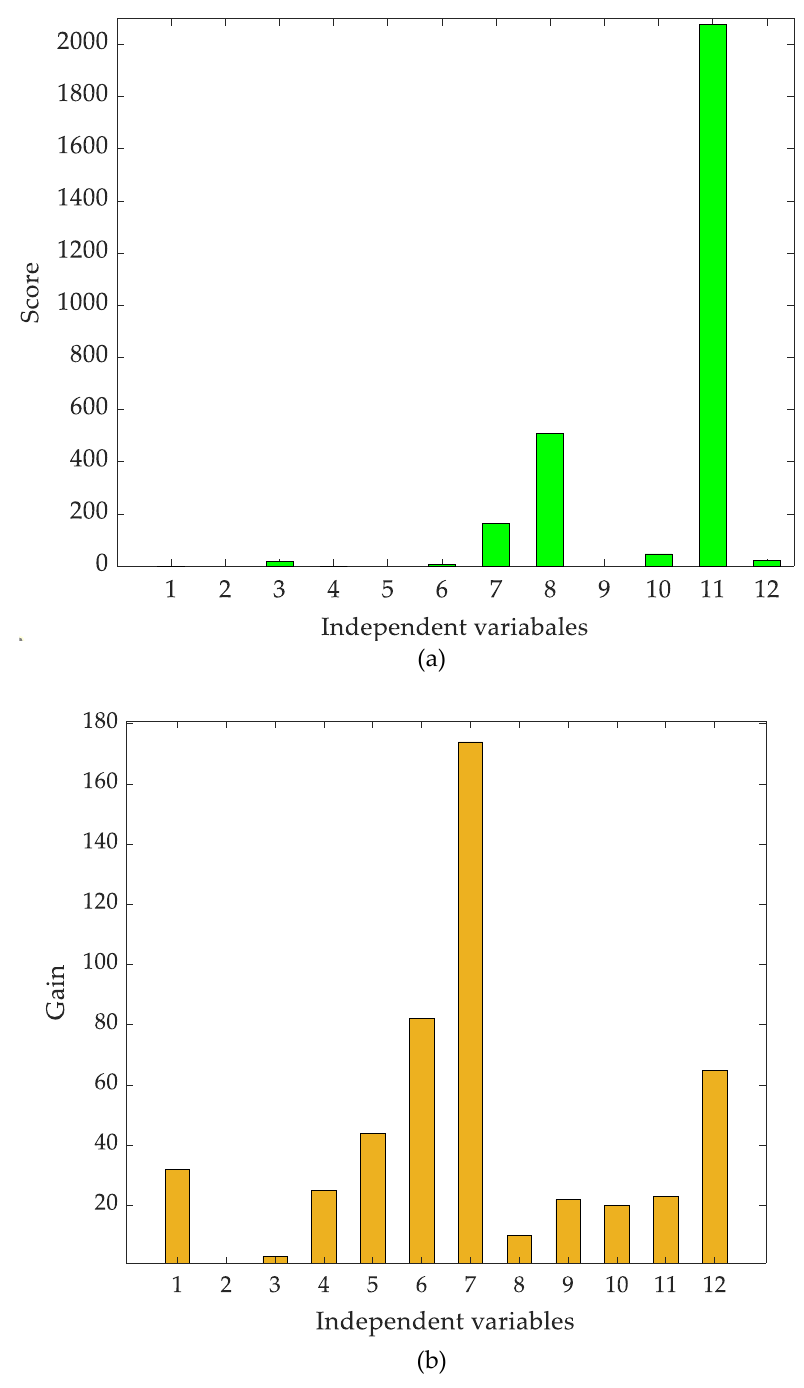
Figure 4. Variable importance : ( a ) scores of variables computed by VIP and ( b ) gains of variables achieved by XGBoost analysis. The x-axis number indicates the serial number of variables (Table 1).